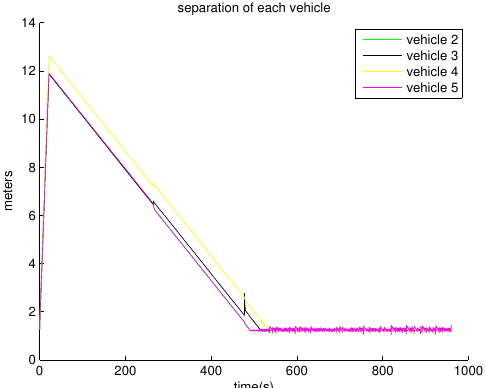
Figure 7. This figure shows the separation between every neighboring truck (scenario 2). γ = 1.001 is used. See that it takes more time in making the separation converge to the desired separation, compared to the case where γ = 1.01 in Figure 5. Compared to the case where γ = 1.01, the separation noise decreases.